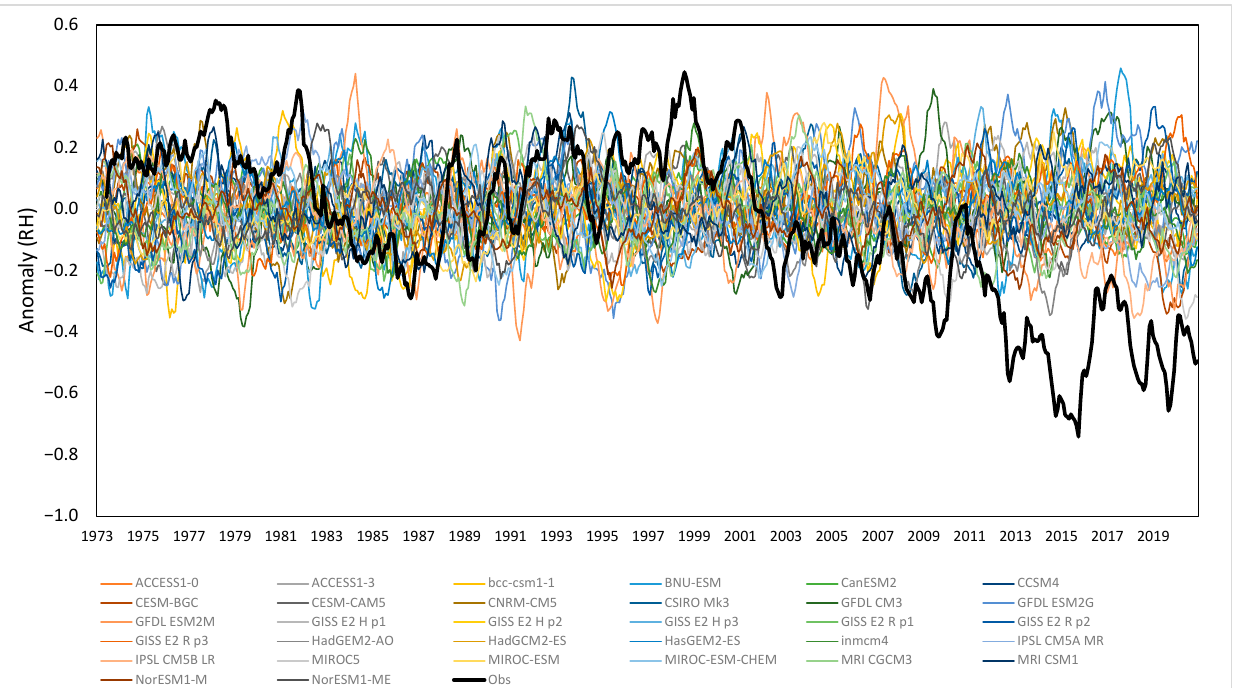
Figure 4. Simulated RH 70° S to 70° N from CMIP5 RCP4.5 compared with observed RH for blended global RH from Had ISDH. Period 1973–2020 with a baseline of 1981–2010, shown as a running 11-month mean.